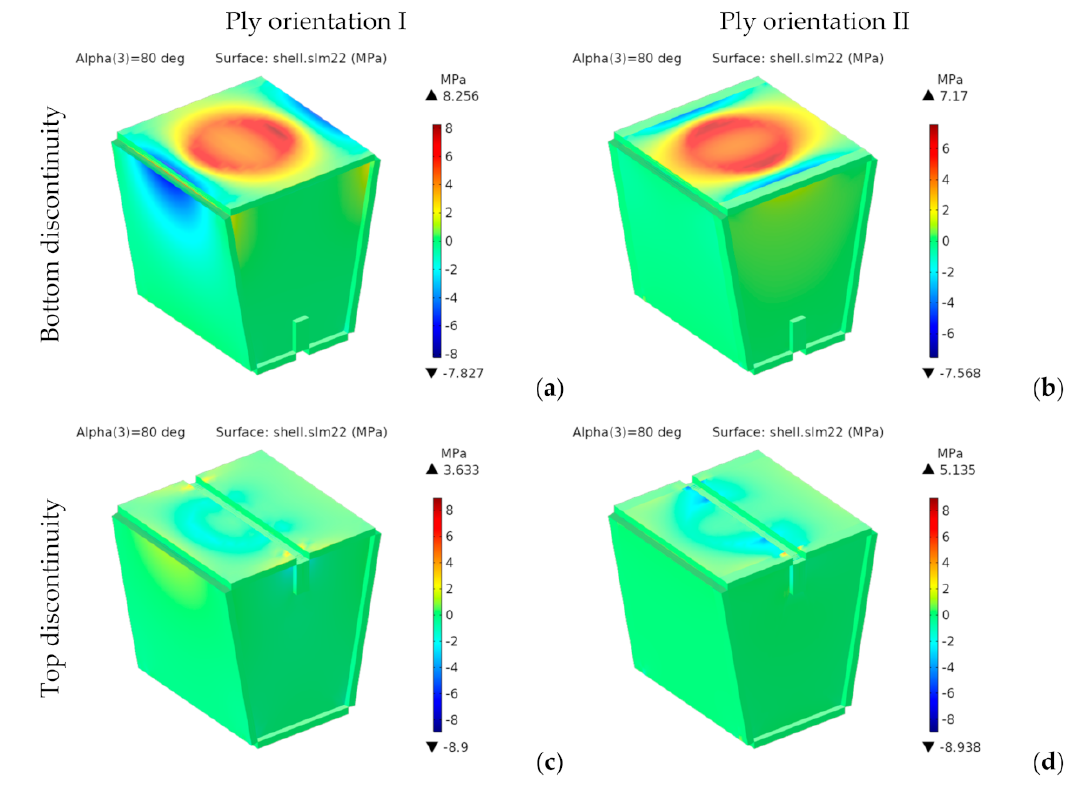
Figure 20. 1st design. Stress σ yy [MPa] for bottom ( a , b ) and top ( c , d ) discontinuity.